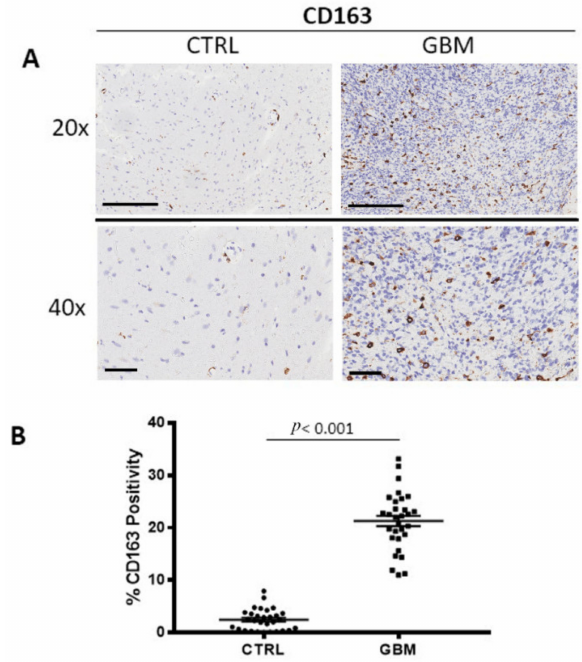
Figure 2. ( A ) Immunohistochemical staining for CD163 as a marker of M2 macrophages in both the center of tumor (GBM) and in the healthy surrounding areas (CTRL). Scale bar: 60 µ m (40 × ), 200 µ m (20 × ). ( B ) Morphometric analysis indicating the percentage of CD163 positivity in GBM and CTRL samples ( B